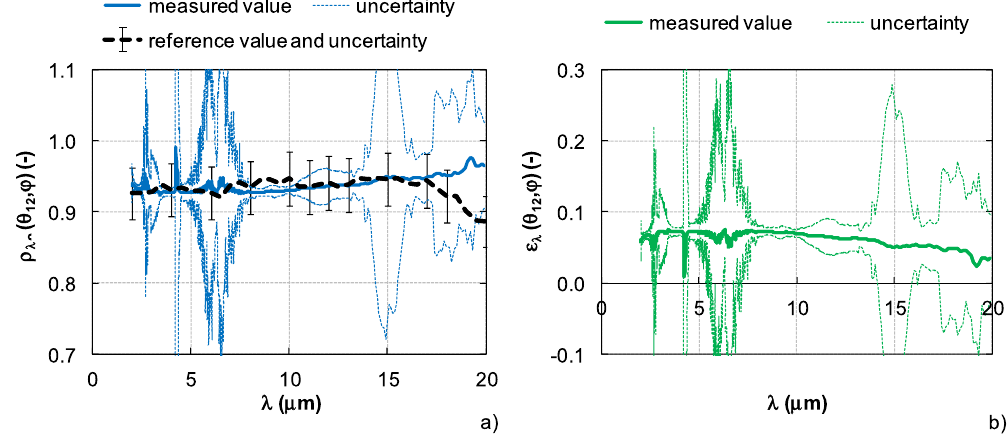
Figure 7. Results of opaque bulk diffuse material – AuStan. ( a ) Measured reflectance vs. reference value. ( b ) Evaluated emissivity.